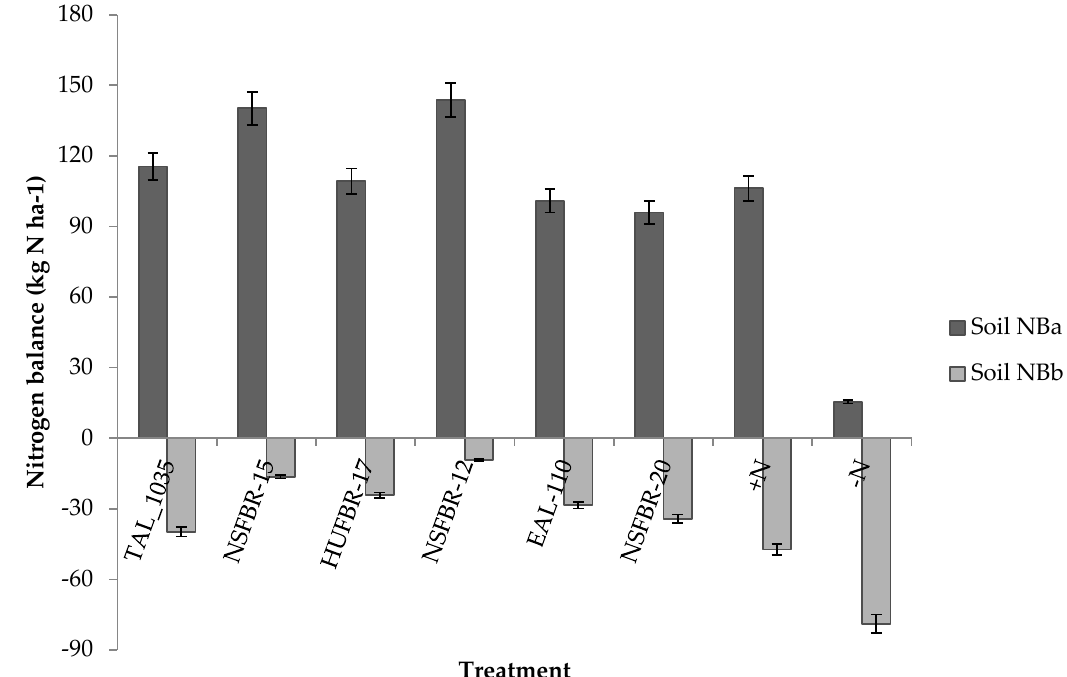
Figure 4. Soil nitrogen balance as influenced by rhizobium strain inoculation. NBa = soil nitrogen balance if only grain is removed; NBb = soil nitrogen balance if both grain and haulm are removed.